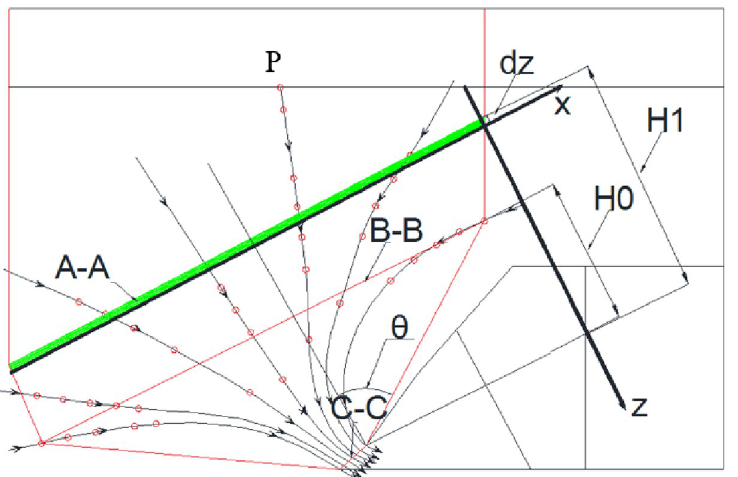
Fig 9. Unsteady flow model of caving materials at the caving window. Point P on the top is the vertex of the spheroid geometry in Fig 6. Section A-A is the boundary between the main roof and caved immediate roof; Section B-B is the coal-roof mass boundary before caving operation; Section C-C is the coal-roof mass boundary at the cease of caving operation. H 1 is the distance from caving window to Section A-A; H 0 is the distance from caving window to Section B-B; dz is the descending distance of Section A-A during a unit time dt.